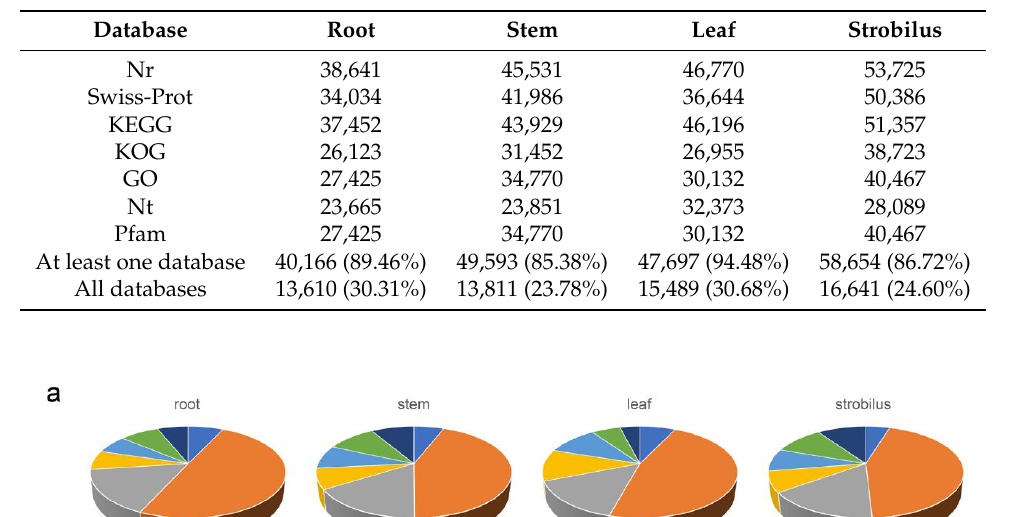
Table 1. Statistics of annotations of the full-length transcripts from four organs of P. chienii with seven databases.